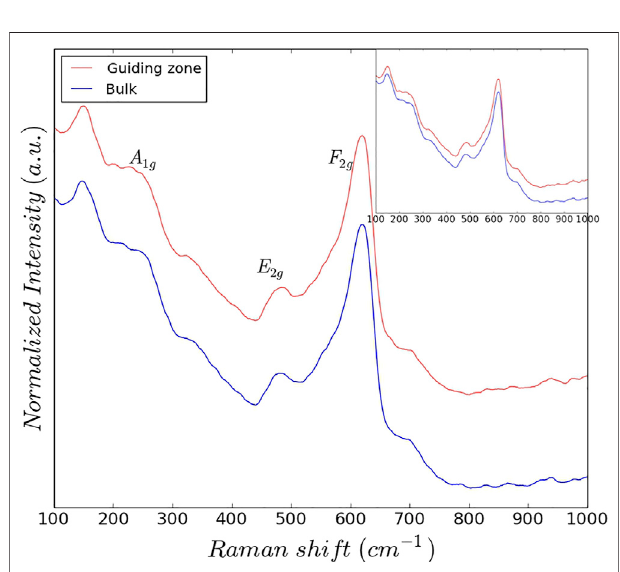
FIGURE 9 | Micro-Raman spectra taken after annealing at a spot within the planar waveguide and at a spot far away from the planar waveguide.